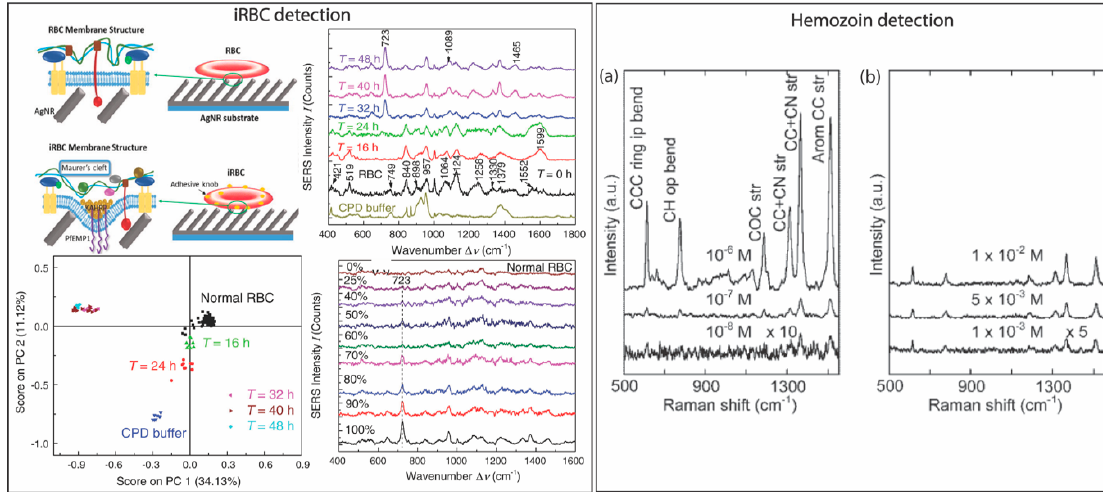
Figure 7. SERS-based malaria metabolite detection. Intrinsic SERS signature of infected red blood cells (iRBC) using silver nanoparticle substrates. (top right) iRBCs with different infection time (up to 24 h: ring stage, after 32 h: late-stage trophozoite and schizont stage iRBCs). (bottom left) Principle component analysis (PCA) score plot for RBCs and different stages of iRBCs based on their SERS spectra. (bottom right) The SERS spectra of the mixtures of RBCs and schizont stage iRBCs at varying percentages. Reproduced with permission from Reference [104] Science Direct (2016). Detection of β -hematin crystals in blood as a malaria metabolite biomarker using magnetic nanoparticles with iron oxide and a silver shell. ( a ) Intrinsic SERS spectra showing the unique peak profile of β -hematin at varying concentrations and ( b ) changes in concentration of the target biomarker. Reproduced with permission from Reference [113] SPIE (2012).